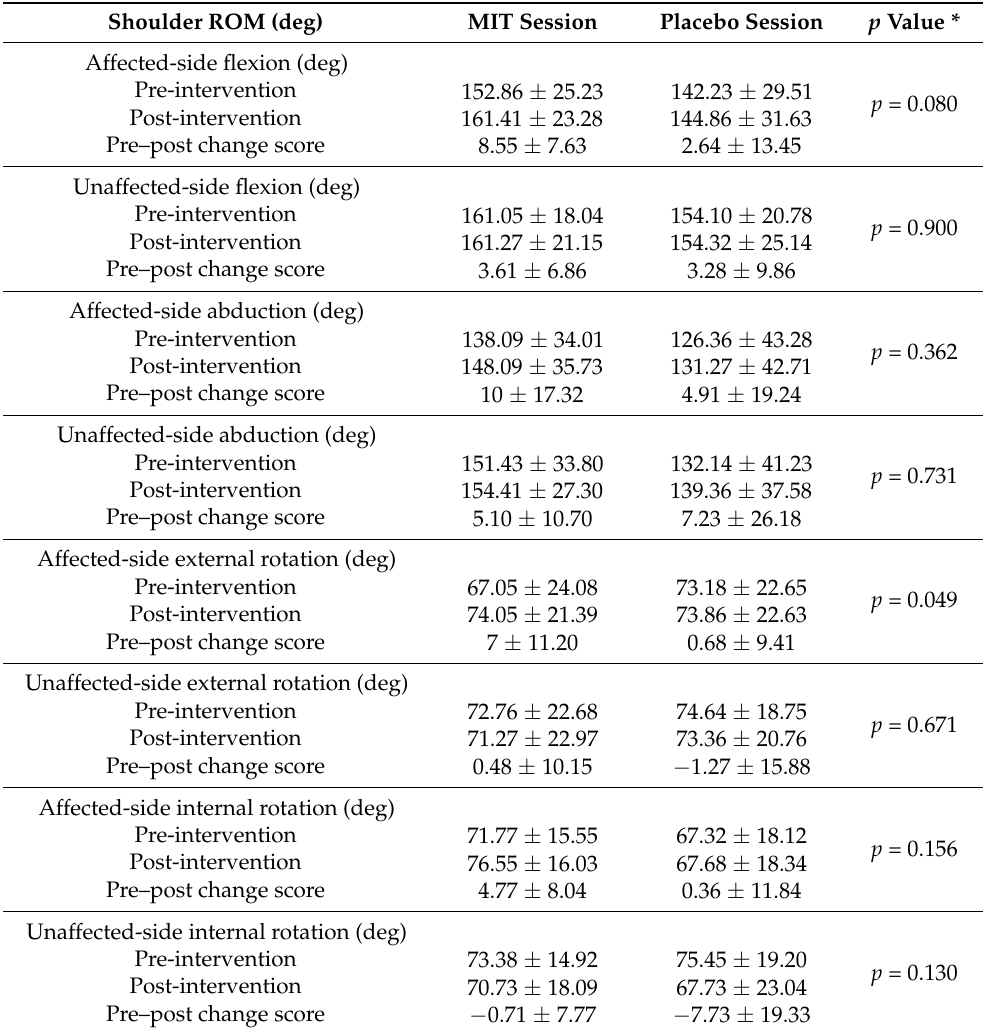
Table 4. Pre-intervention, post-intervention, and change scores for shoulder ROM ( n =